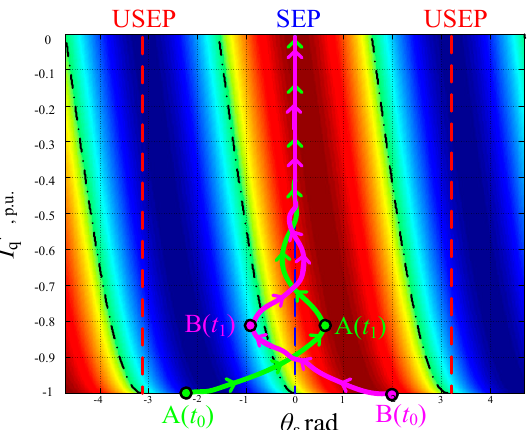
increases as I ∗ q decreases. The d I increases as * I decreases. d q